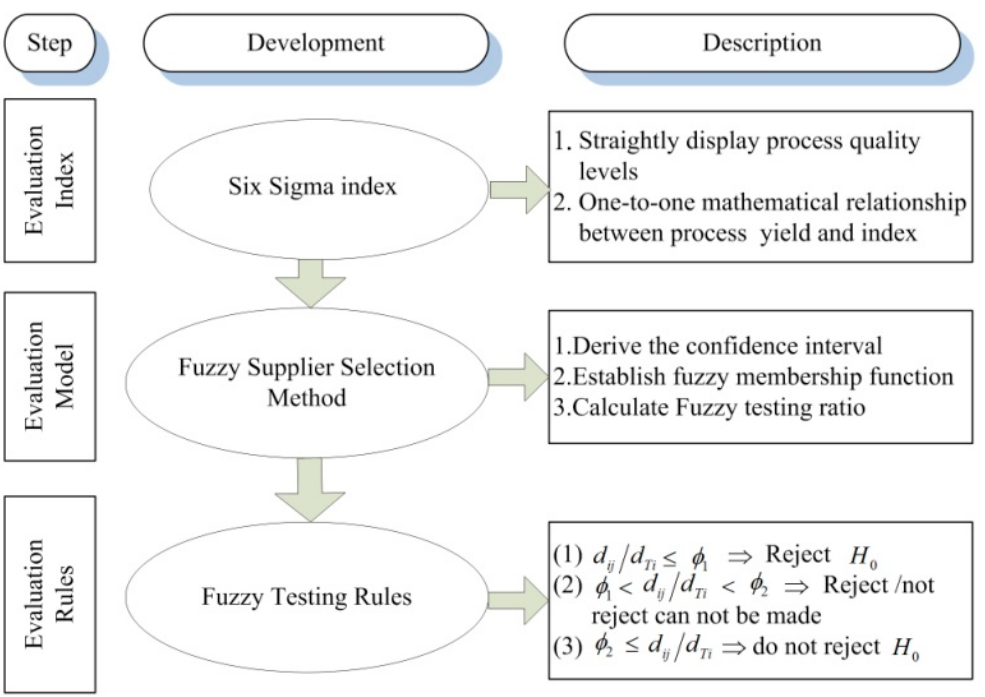
Figure 1. Research design flowchart.